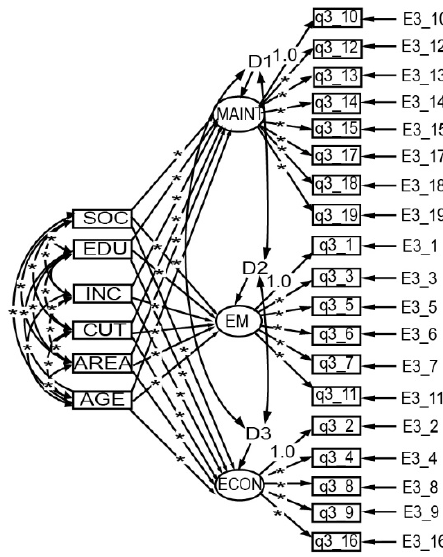
Figure 3. A MIMIC model to test for the effects of a socio-economic type of holding (SOC), formal education (EDU), monthly income (INC), mean annual cut in the last decade (CUT), total forest area of the owner’s holding (AREA), and age (AGE) on the three factors representing conceptualizations of forest management (MAINT, EM, ECON). Regression-like error terms are represented with E, disturbance terms associated with factors are represented with D. The parameters to be estimated are denoted with an asterisk (*).